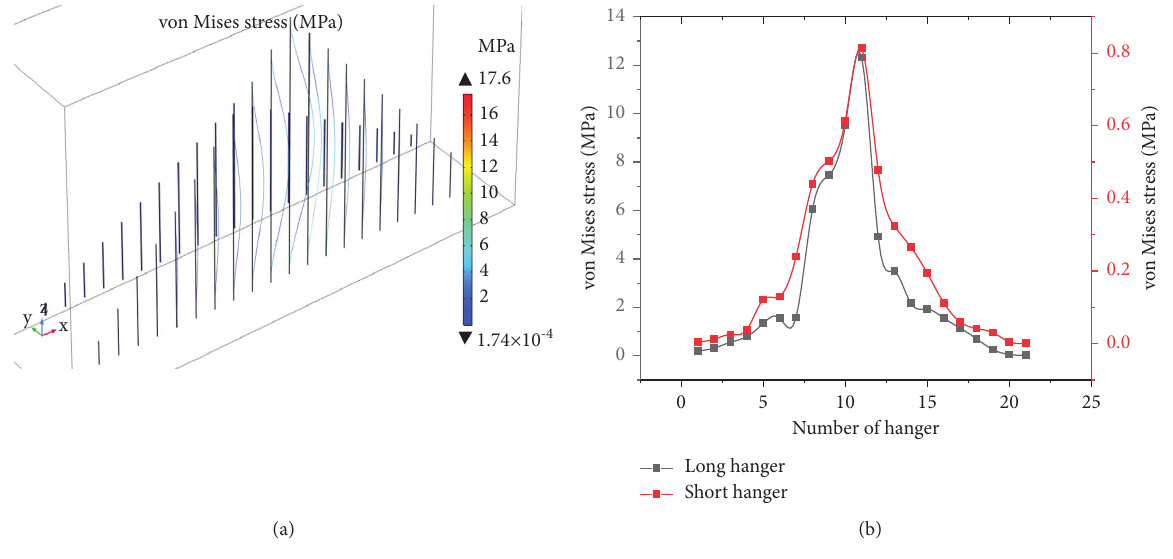
Figure 4: Stress distribution of hangers (wind direction � 0 ° /180 ° ).